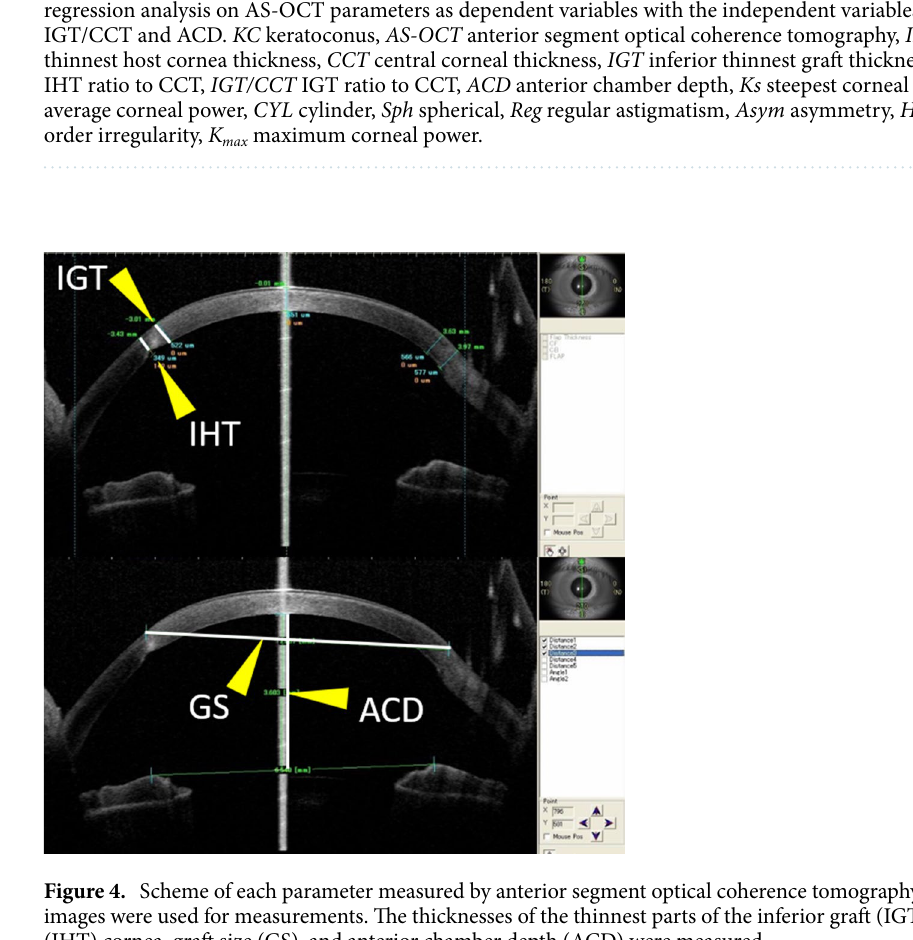
Table 4. Factors associated with corneal powers and astigmatism in the KC and Others groups: Multivariant regression analysis on AS-OCT parameters as dependent variables with the independent variables IHT/CCT,